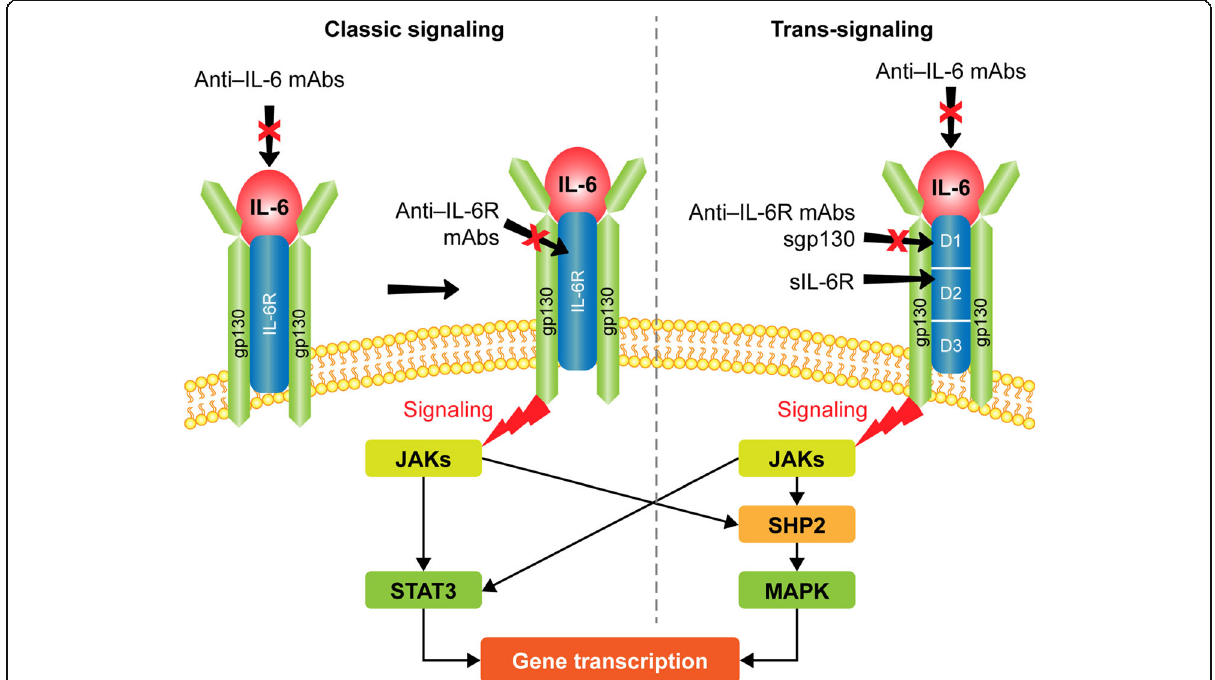
Fig. 1 IL-6 signaling. D1 – D3, subdomains of IL-6R α ; gp130, glycoprotein 130; IL-6, interleukin-6; IL-6R, interleukin-6 receptor; JAK, Janus kinase; mAb, monoclonal antibody; MAPK, mitogen-activated protein kinase; sgp, soluble glycoprotein 130; SHP2, Src homology region 2 domain – containing phosphatase-2; sIL-6R, soluble IL-6R; STAT3, signal transducer and activator of transcription